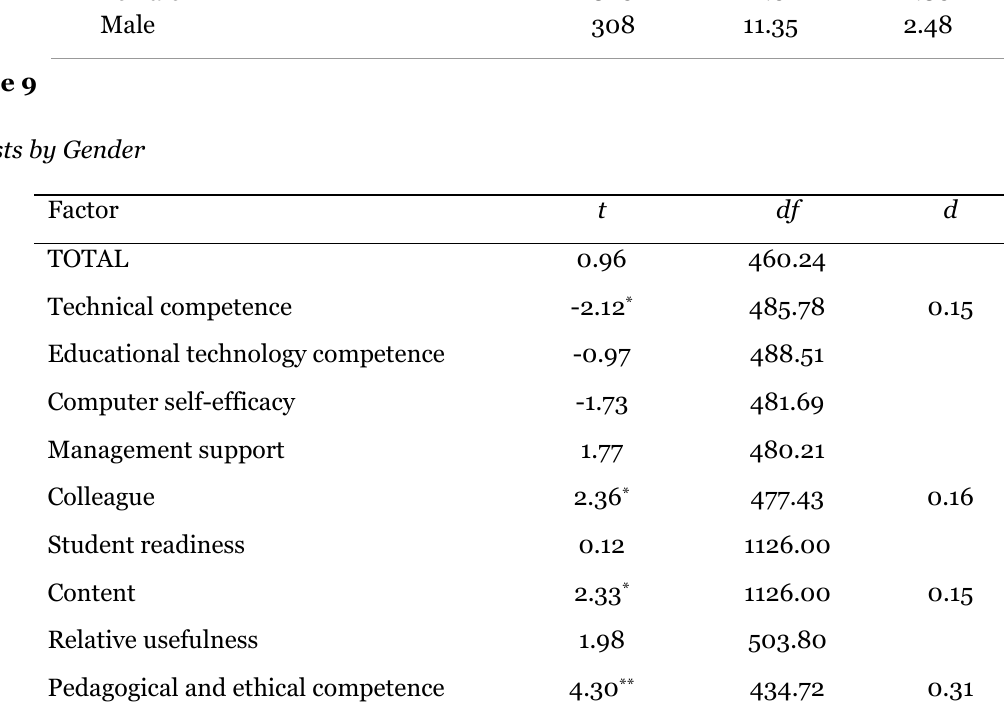
Management support